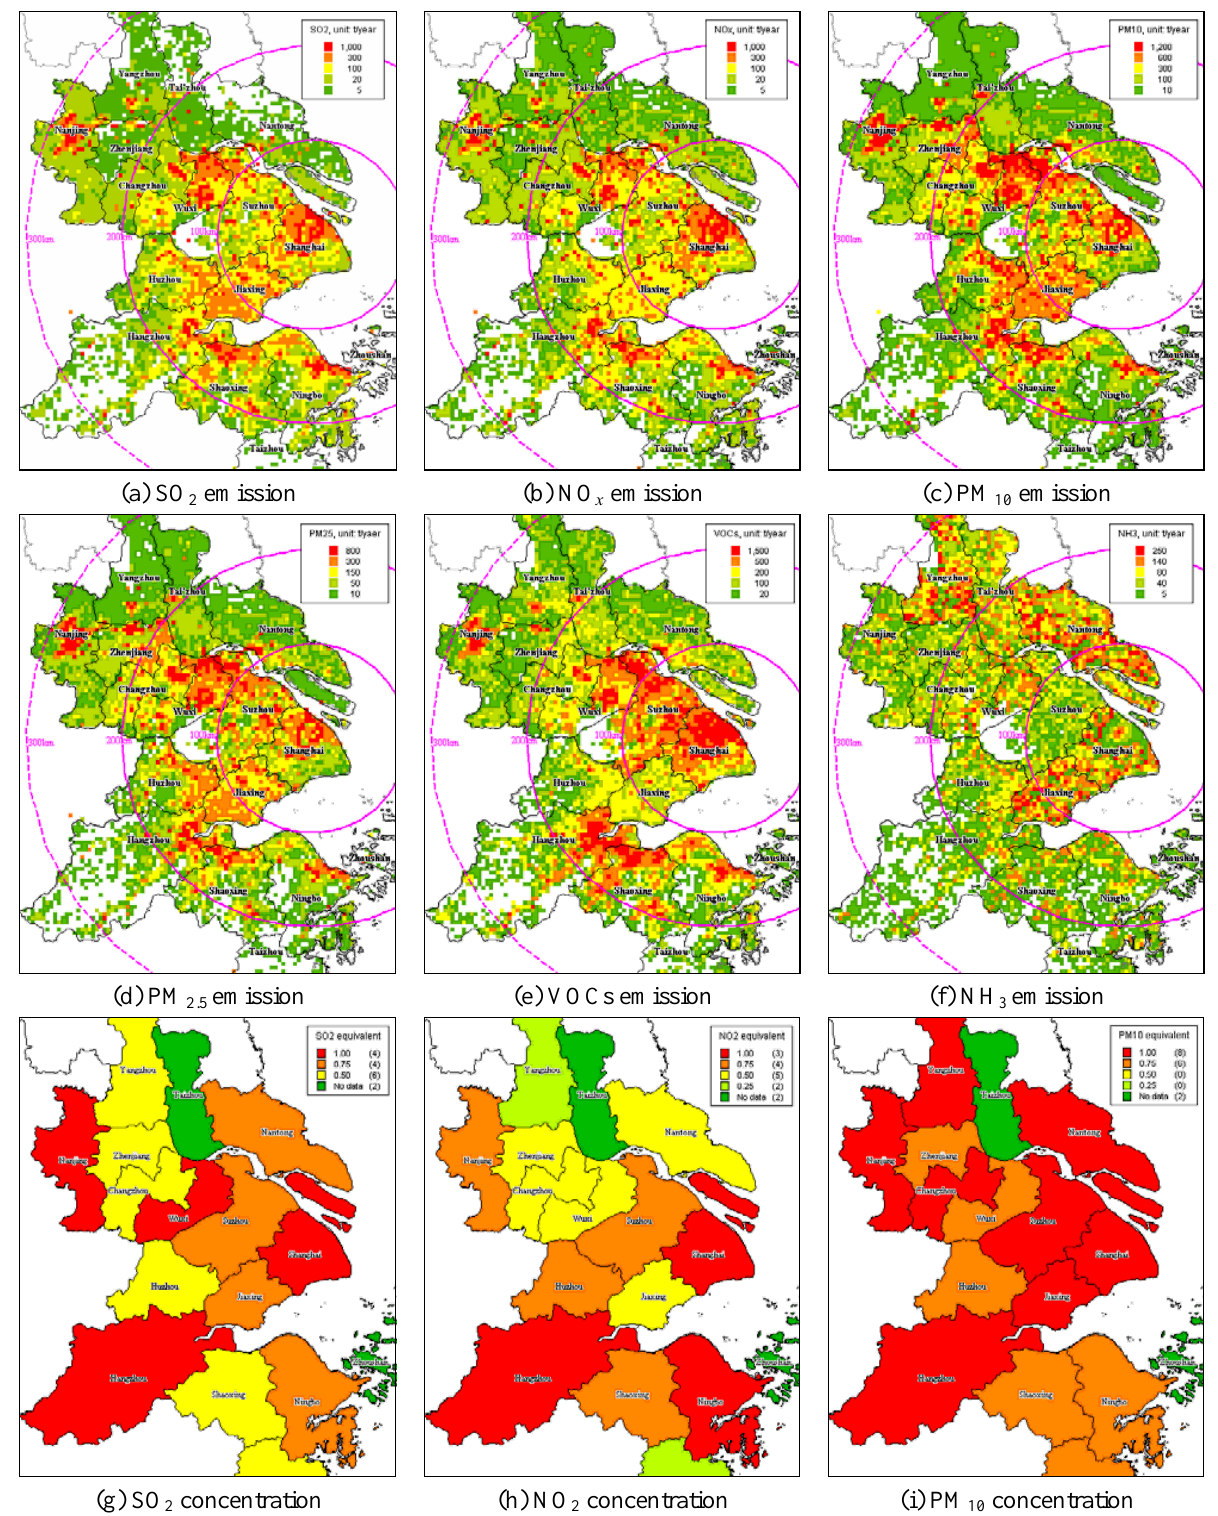
Fig. 2. Spatial allocation of air pollutant emissions and annual concentrations in the YRD region in 2007.